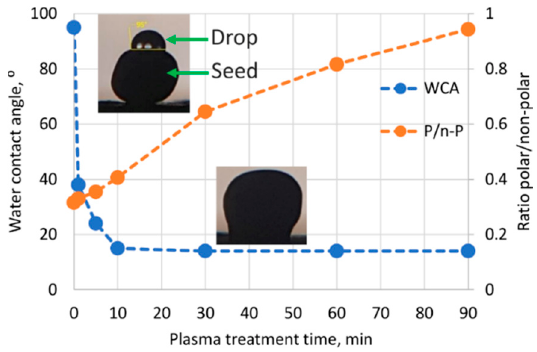
Figure 6. Water contact angle (WCA) and polar / non-polar groups ratio (P / n-P) dependence on the plasma treatment time.